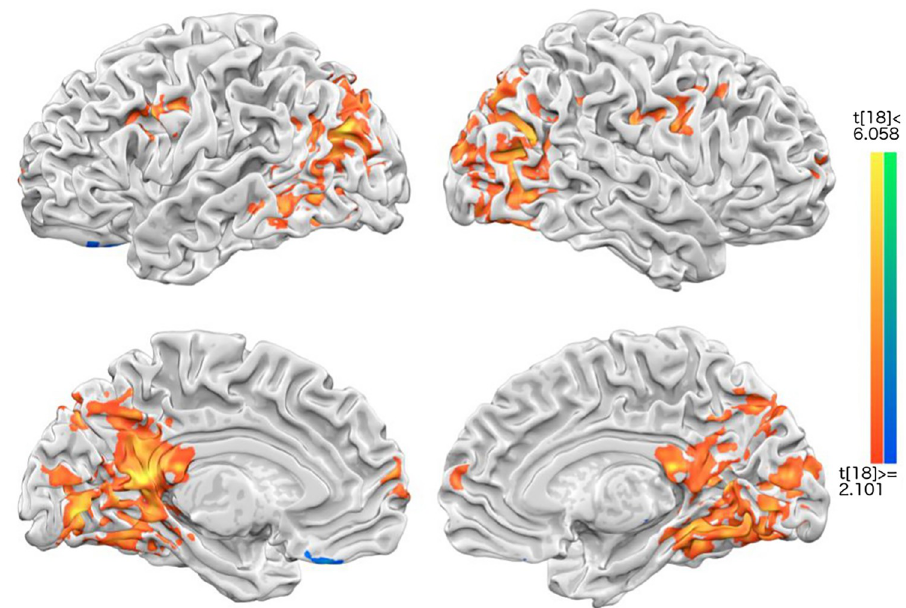
Fig 6. The result of multi-voxel pattern searchlight analysis, with searchlight radius 2 (yielding 5x5x5 = 125 voxels). The brain regions included medial prefrontal gyrus (MPFC), posterior cingulate gyrus (PCC), Precuneus (Prec), precentral gyrus, and superior frontal gyrus, that were significantly above chance (50% classification performance) between Interpersonal and Intrapersonal wellbeing, in a group level.